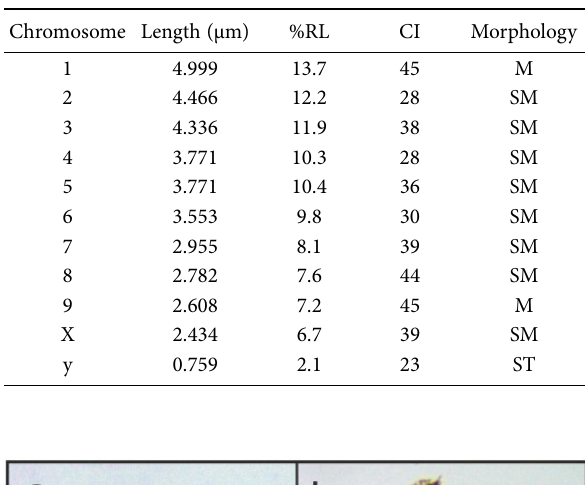
Table 1. Chromosome morphologies and measurements of Accan- thopus velikensis. CI: centromere index, RL: relative length. (Cen- tromere positions were determined according to Levan et al. 1964).